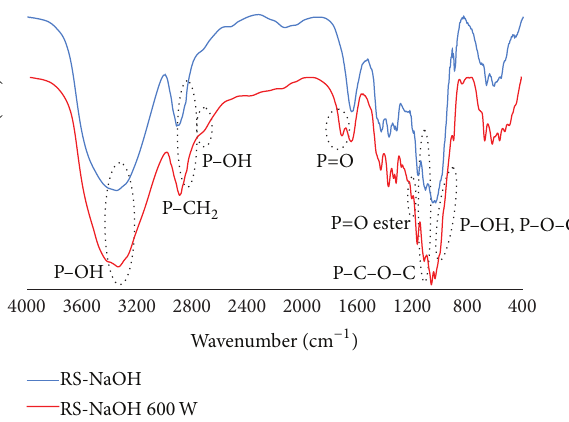
Figure 4: IR spectra of unmodified rice straw after treatment by NaOH solution (RS-NaOH) and modified rice straw (RS-NaOH 600